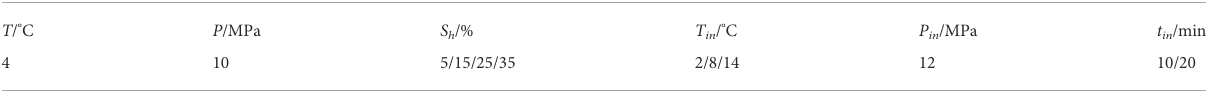
TABLE 4 The experimental conditions for the mechanical test of hydrate-bearing sediments in the intrusive state. T in and P in represent the drilling fl uid temperature and invasion pressure respectively, and t in represent the invasion time. Gas hydrate-bearing sediment